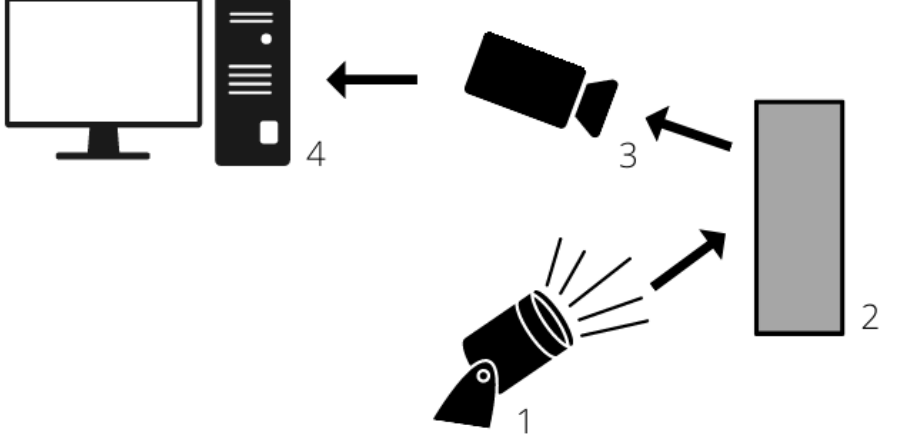
Figure 2. Measurement principle of infrared